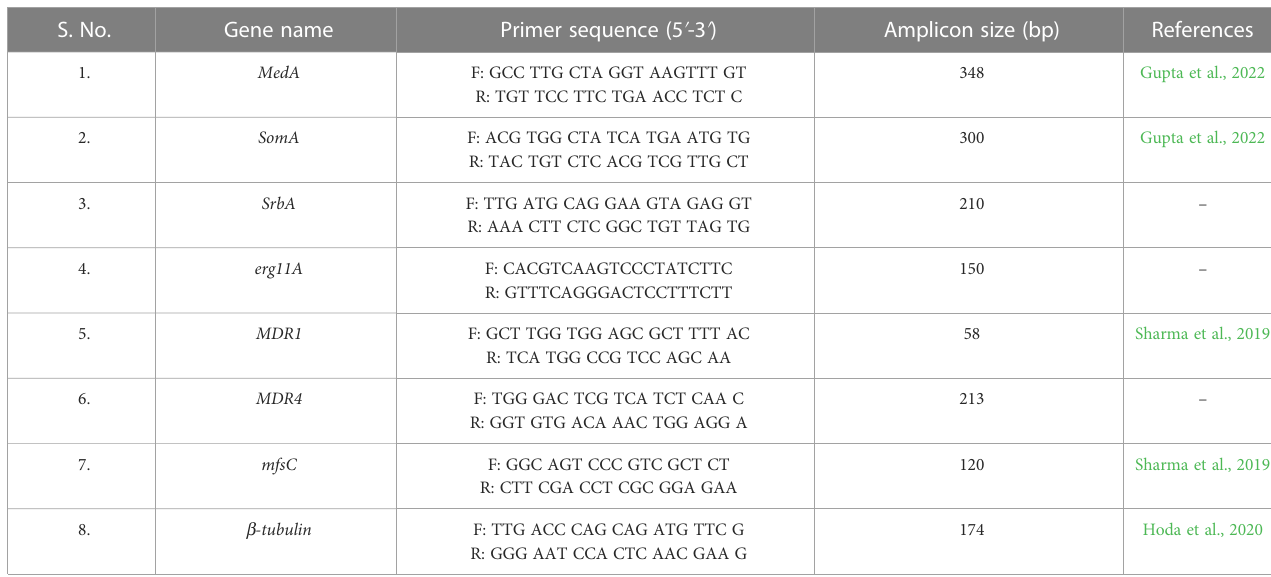
TABLE 1 Primers used for